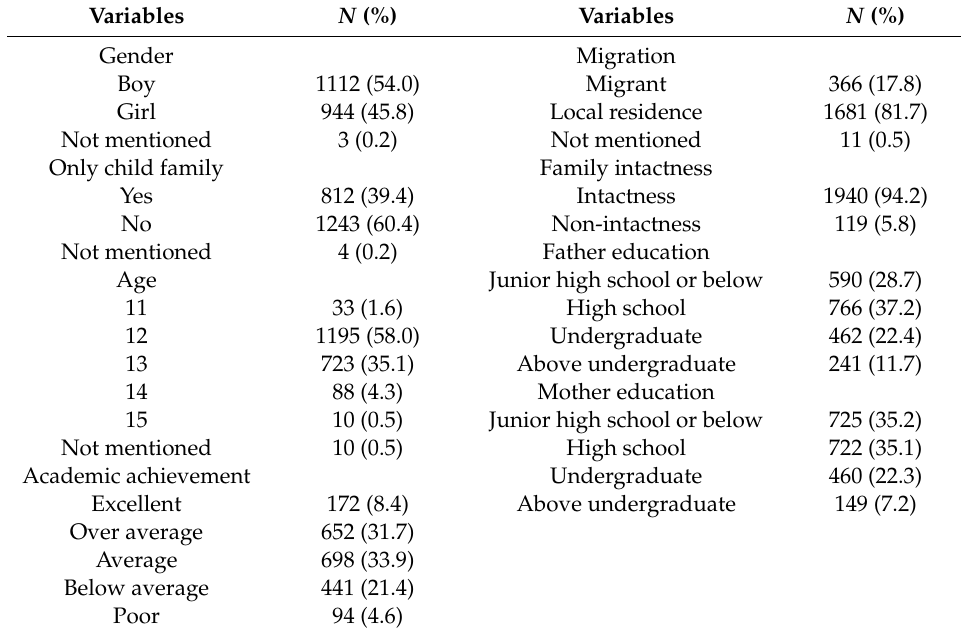
Table 1. Socio-demographic characteristics of the study